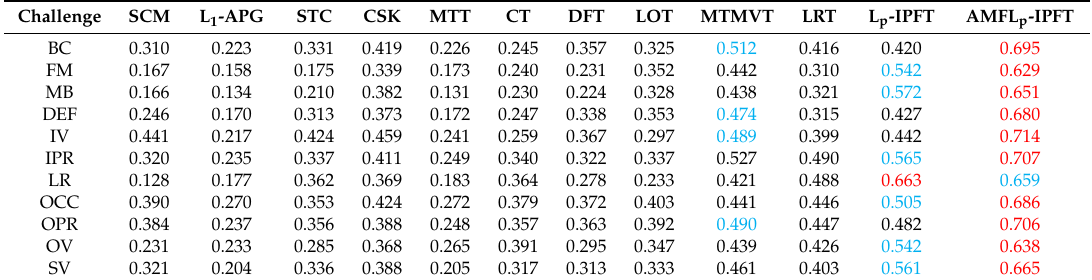
Table 3. ACU results of each tracker on sequences with different challenge for OPE about precision.